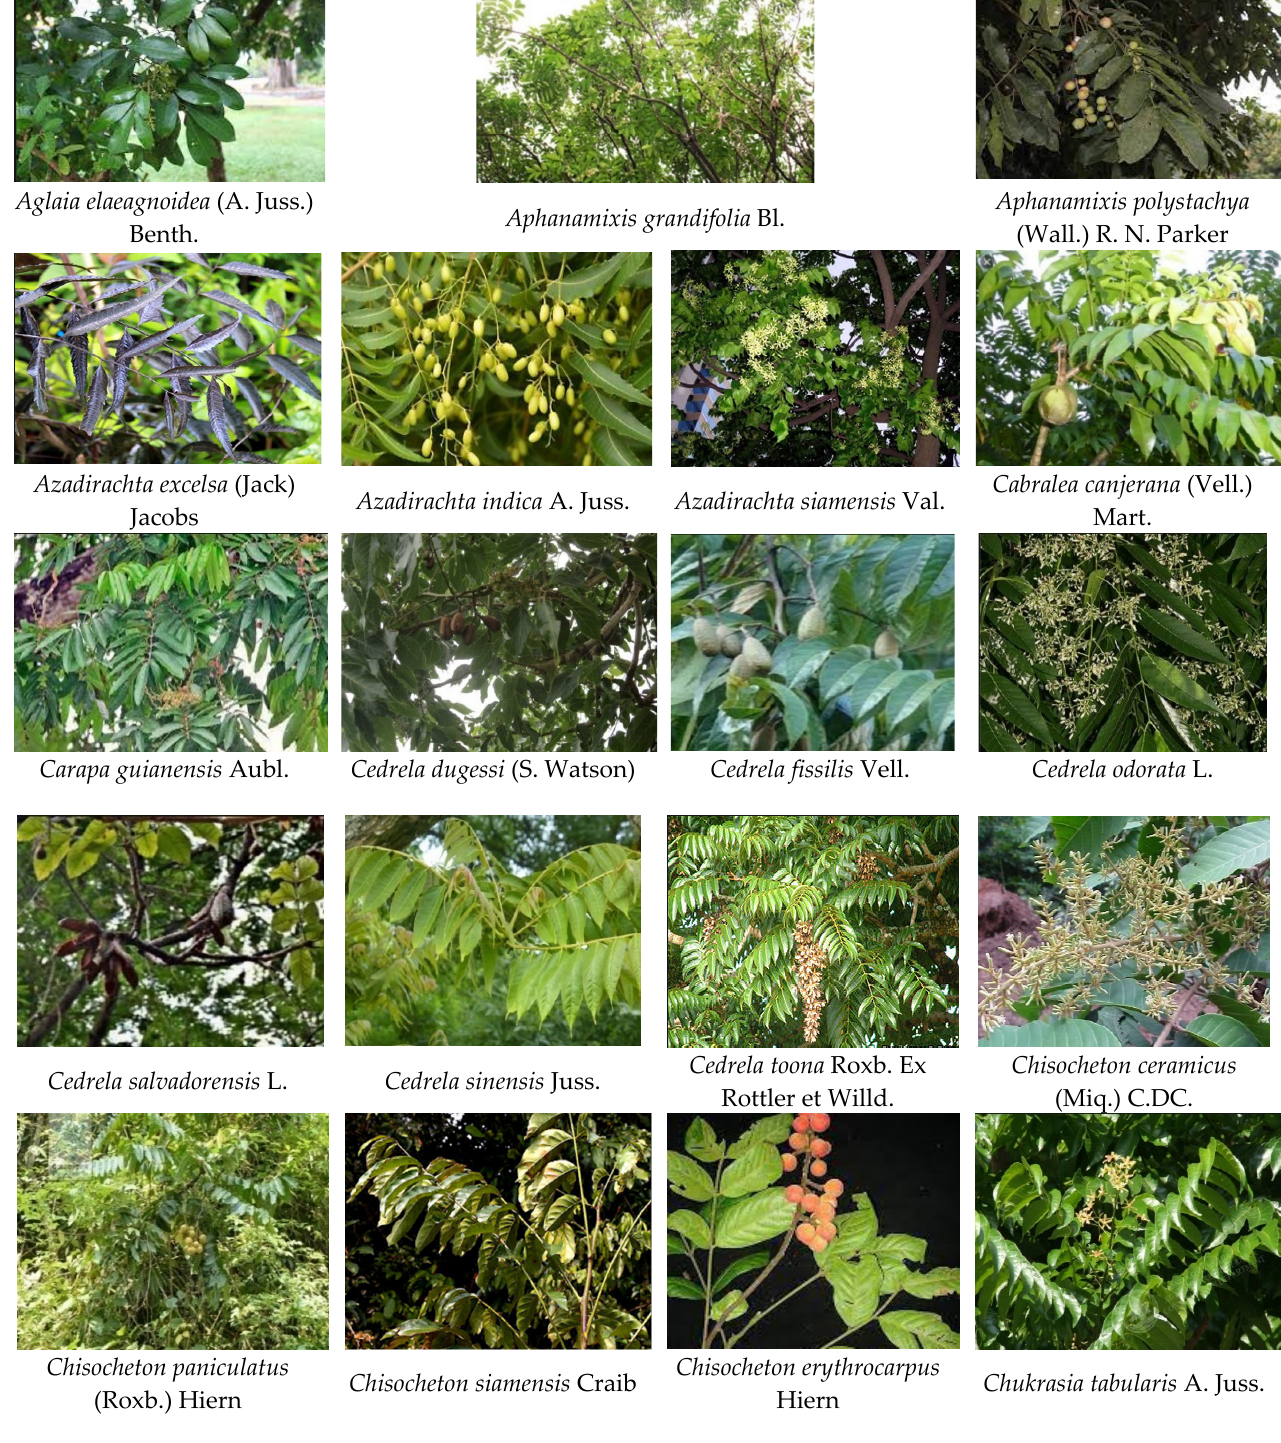
Figure 2. The 19 insecticidal plant species from genera Aglaia , Aphanamixis , Azadirachta , Carapa , Cedrela , Cabralea , Chisocheton , and Chukrasia in Meliaceae. Table 1. The 19 insecticidal plant species of 8 genera in Meliaceae.